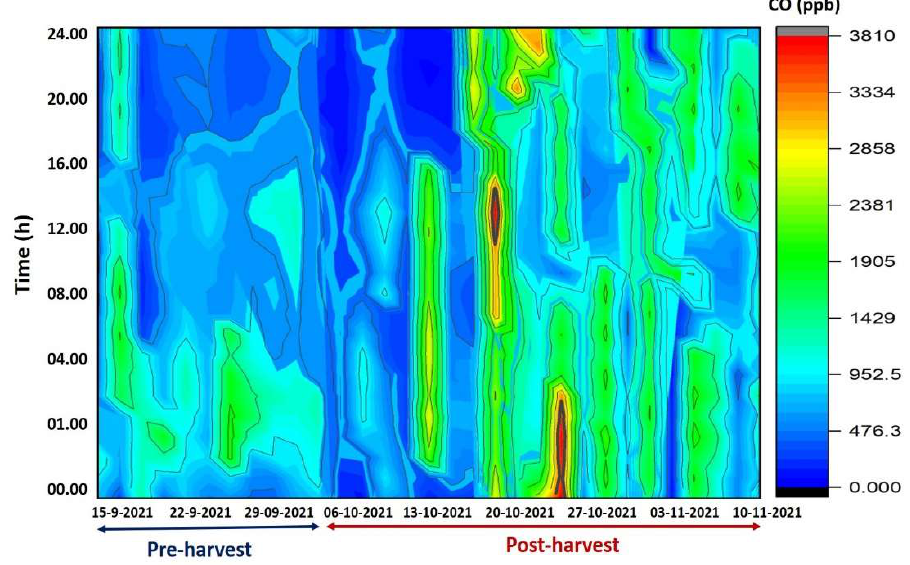
Figure 6. Contour showing hourly variation of CO during the pre-harvest and post-harvest periods.